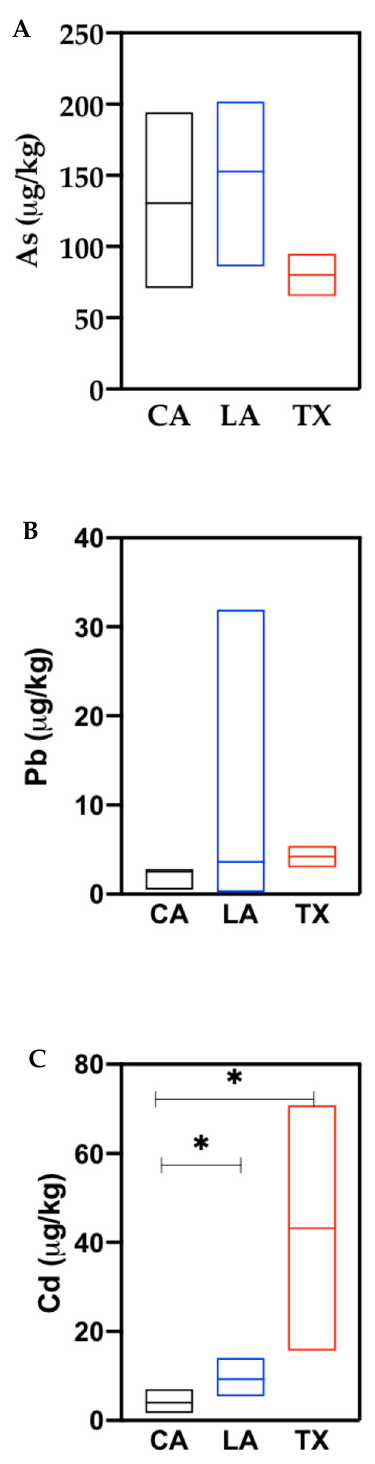
Figure 1. Toxic elements (As, Pb, and Cd) concentrations in white rice from the US (corresponding to Figures 1A, 1B and 1C respectively); the lines in the plots show median concentrations. Statistically significant (* p < 0.05) concentrations are based on non-parametric tests of the means.